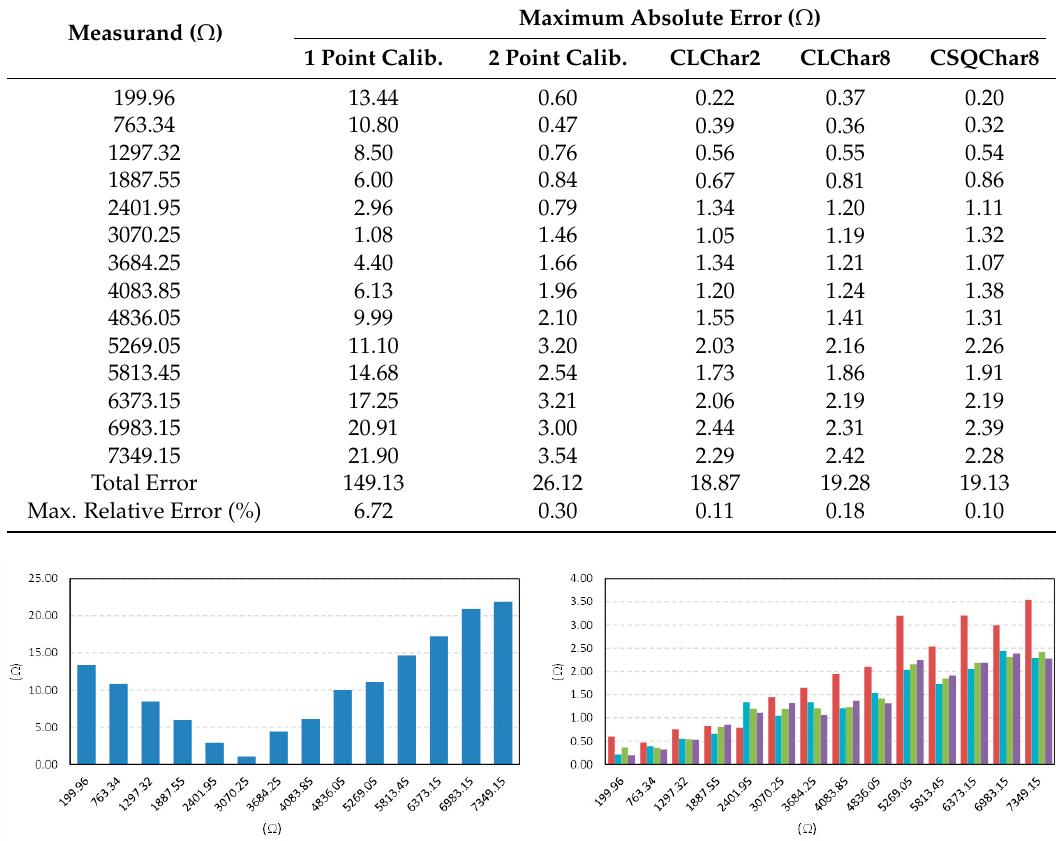
Table 3. Accuracy data for the tactile sensor and different calibration techniques. Measurand ( Ω )